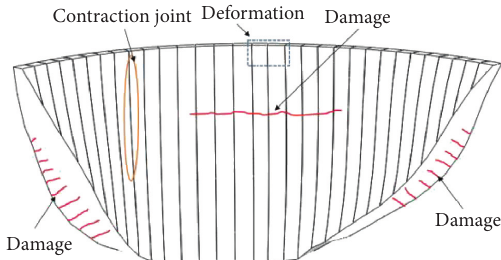
Figure 2: Typical failure modes for arch dams.